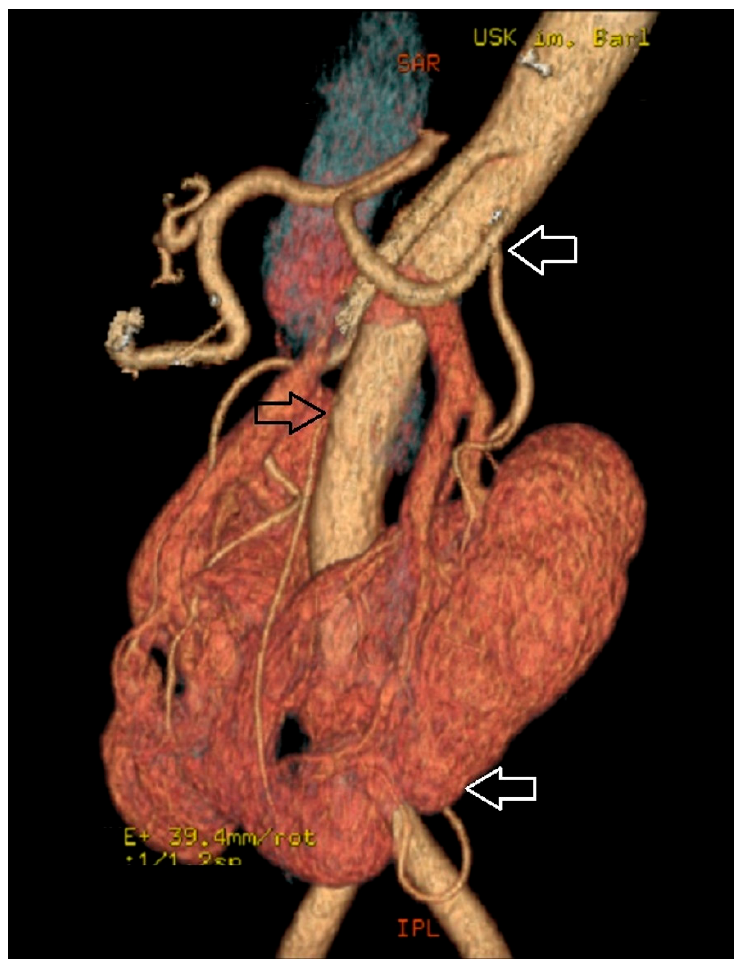
Figure 2. Horseshoe kidney supplied by supernumerary arteries, the first originating from the aorta above the inferior mesenteric artery and the second branching from the left common iliac artery.